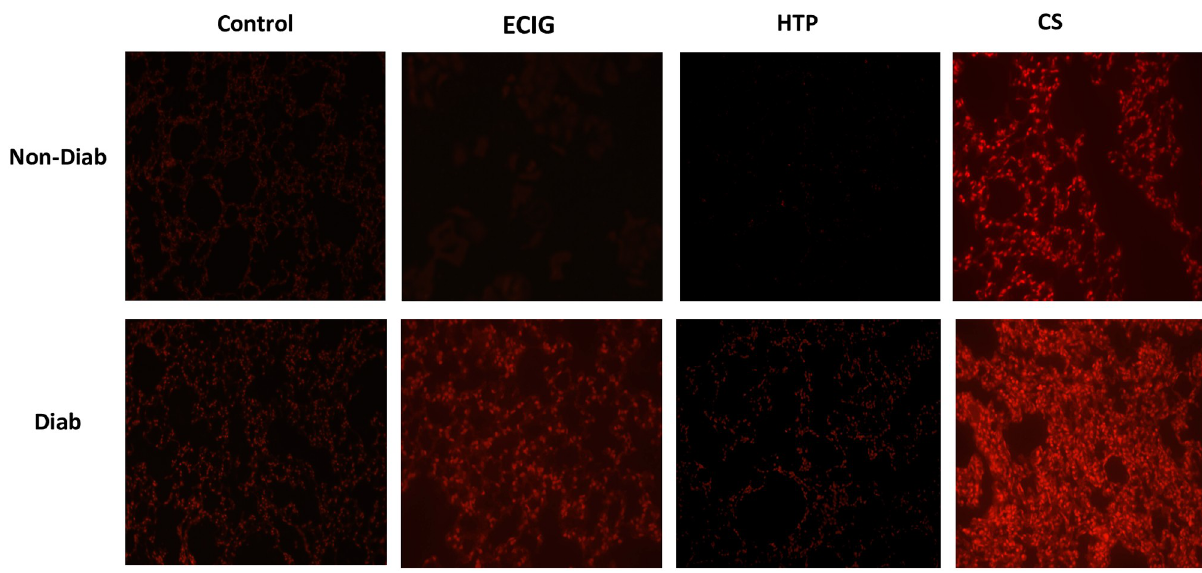
Fig 4. ROS detection in lung tissues. Five μ m thickness slides of lung sections for Control, ECIG and CS from Non-Diabetic and diabetic mice were incubated with Dihydroethidium (DHE), and fluorescent images of ethidium-stained tissue were analyzed. ROS levels were significantly higher in ECIG and CS and exposed diabetic mice when compared to ECIG and CS Non-Diabetic mice exposure respectively.